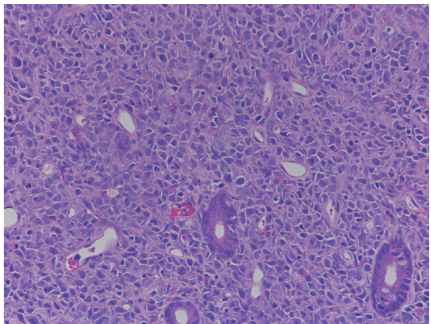
Figure 2: Hematoxylin and eosin stain showing intestinal glands surrounded by large pleomorphic lymphoid cells (magnification ×